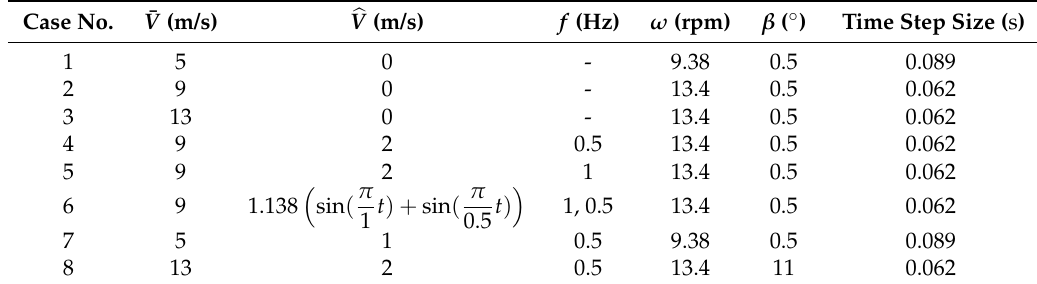
Table 1. Setting of cases.